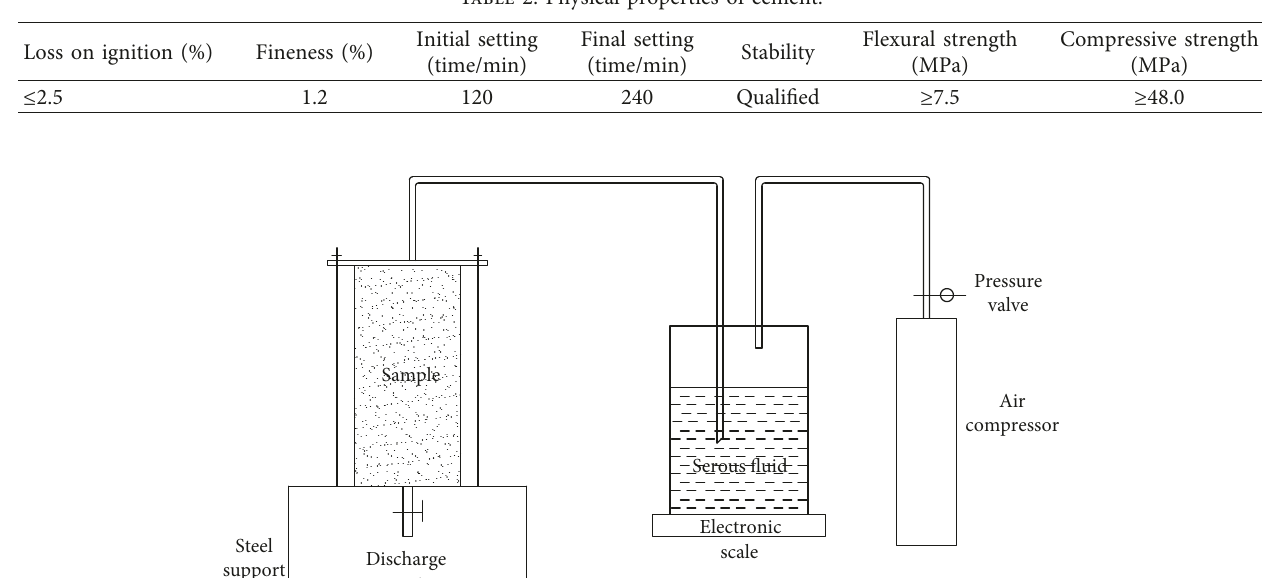
Table 2: Physical properties of cement.